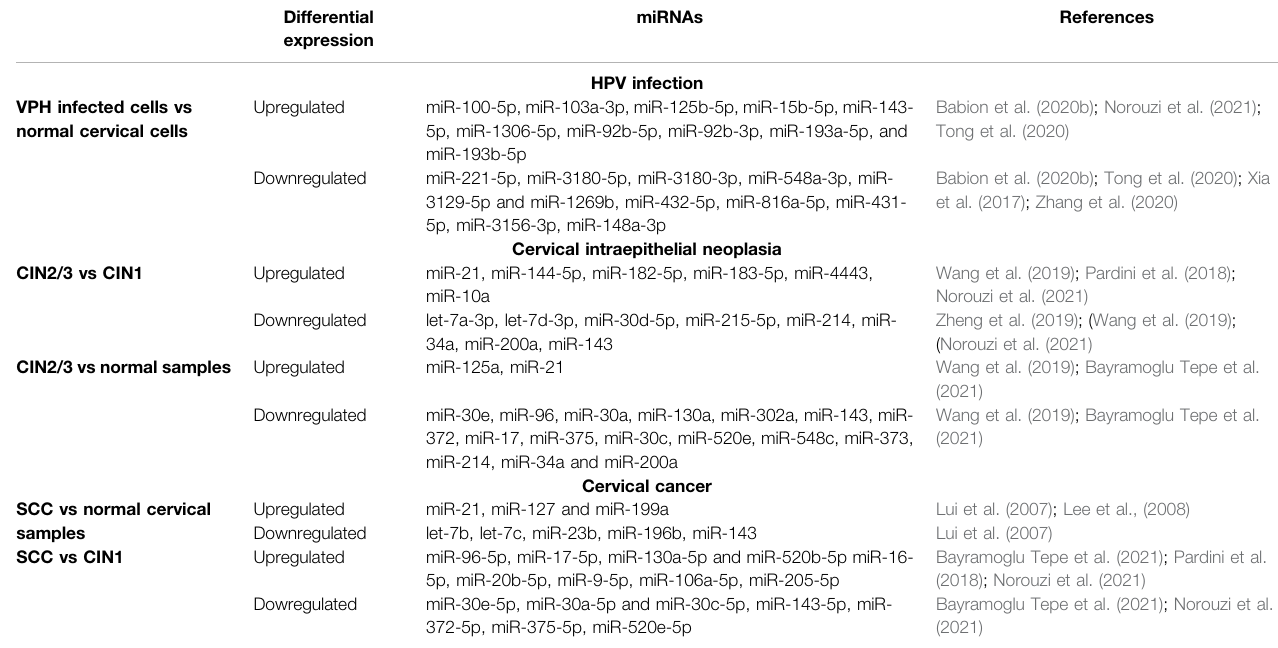
TABLE 1 | Differential expression of miRNAs in cervical carcinogenesis. CIN, cervical intraepithelial neoplasia; SCC, squamous cervical